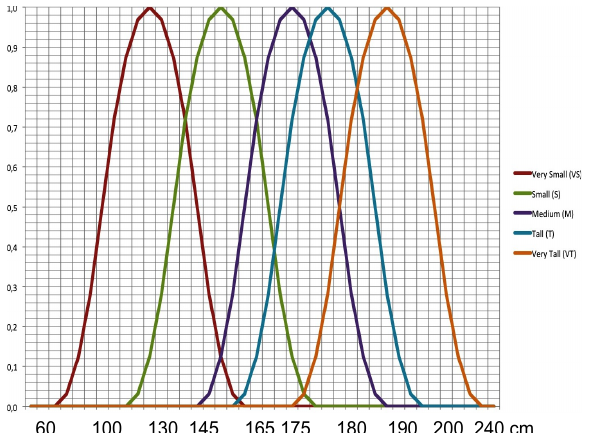
Figure 2. Bell membership functions representing the different size classes in